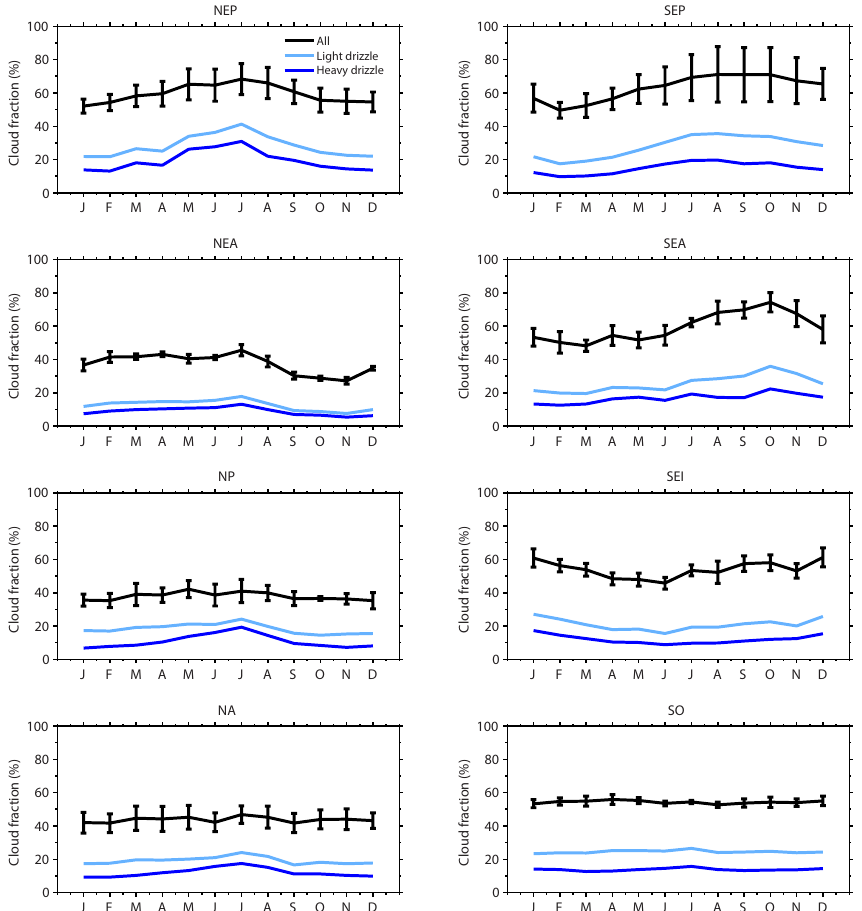
Figure 3. Seasonal cycle of cloud fraction for all low clouds (black) and low clouds with light (light blue) and heavy (dark blue) drizzle. Light and heavy drizzle conditions are categorized based on column maximum radar reflectivities with radar reflectivities in the range of − 15 to 0dBZ for light drizzle and above 0dBZ for heavy drizzle. Each geographical region is shown in Fig. 2 and defined in Table 1. Vertical bars indicate one standard deviation. Statistics are based on 5 years of Cloudsat/CALIPSO data.